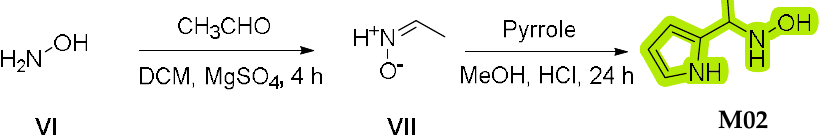
Figure 14. Traditional method for the preparation of compound M03 . Starting material VIII is com- mercially available. Figure 13. Alternative synthetic route for the preparation of M02 . Starting material VI is commercially available.